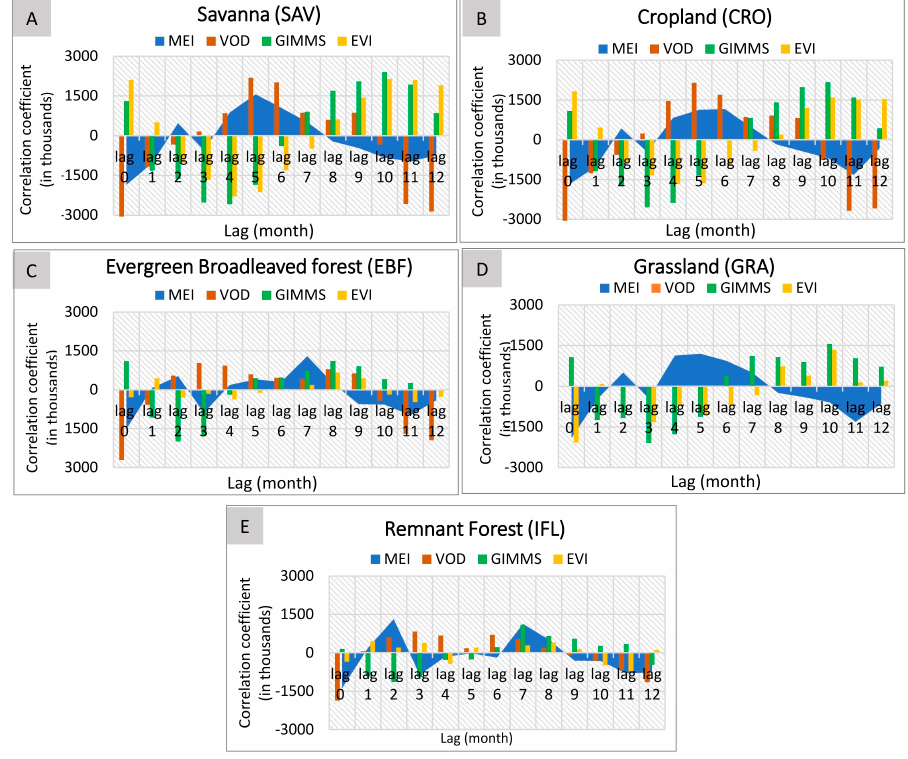
Figure 8. Significant CCF coefficients of rainfall to RS proxies from lag 0 to 12 months over different vegetation cover types, such as ( A ) savanna; ( B ) cropland; ( C ) evergreen broadleaf forest; ( D ) grassland; and ( E ) remnant forest.